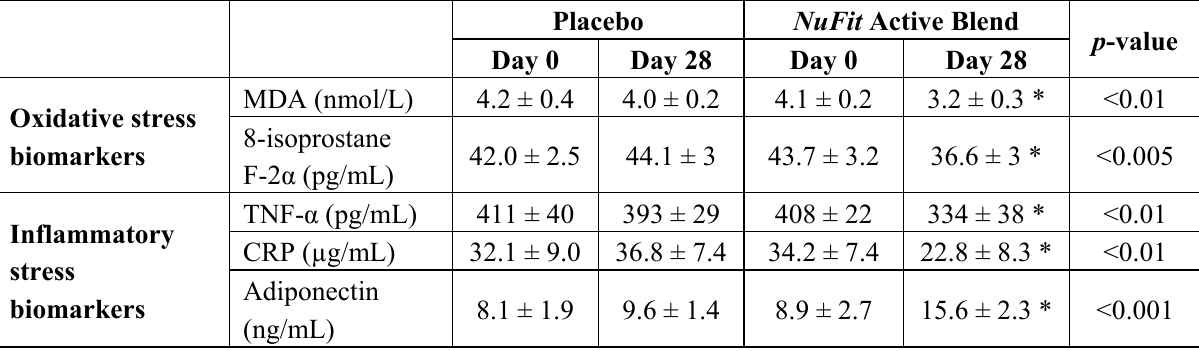
Table 3. The effects of the NuFit active blend and Placebo on oxidative and inflammatory stress biomarkers. Twenty overweight or obese subjects received the NuFit active blend or placebo for 4 weeks. At the end of the intervention, plasma oxidative and inflammatory stress biomarkers were evaluated. Values are expressed as mean ± SE. * Denotes significant treatment effect at the indicated p -value; there were no significant differences in baseline (day 0) values between placebo and active